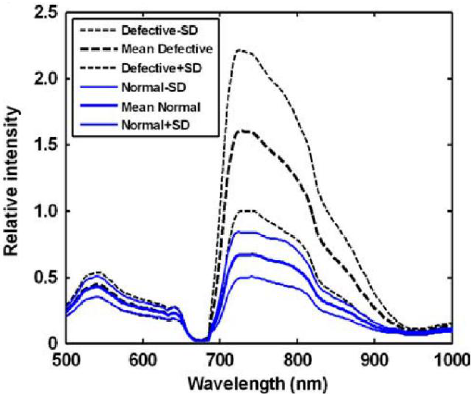
Figure 15. Typical reflectance (500–675 nm) and transmittance (675–1000 nm) spectra of normal and defective cucumbers. SD in the figure represents the standard deviation. Reproduced with